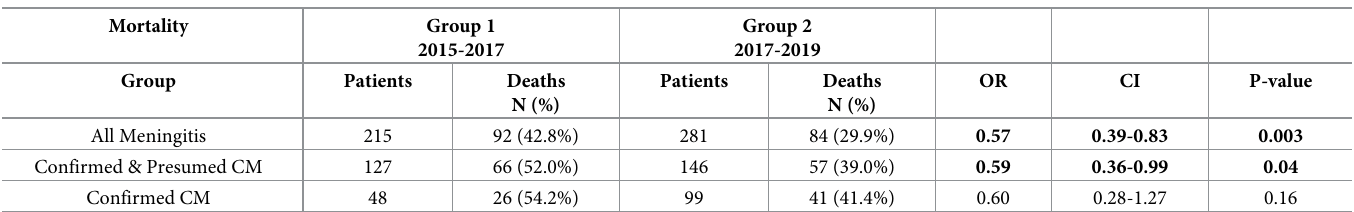
Table 6. Impact of the CM-DTP on